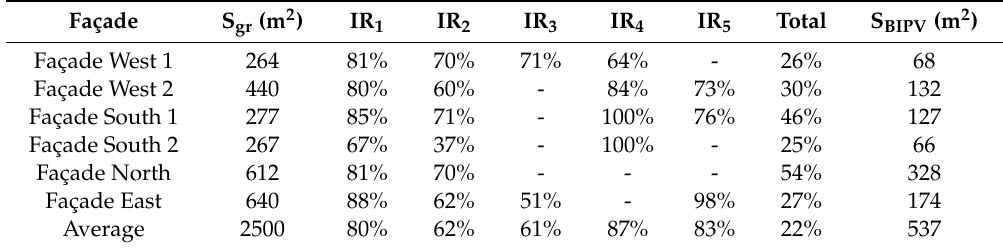
Figure 8. Examples of calculation of IR 3 and IR 4 for the south façades of the L-shaped building. Table 8. Reduction factors for the façades of the L-shaped